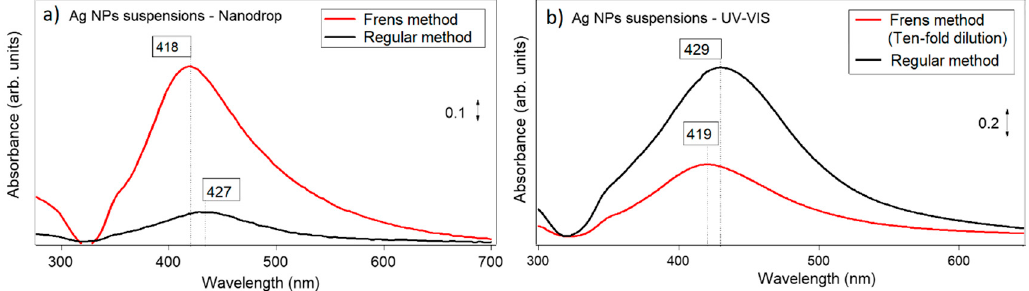
Figure 2. Absorbance spectra of Ag nanoparticles obtained with the regular method and with the Frens method, using a Nanodrop instrument ( a ) and a UV-Vis spectrometer ( b ). The suspension obtained via the Frens method exceeded the maximum measurement of the UV-VIS spectrometer ( b ); for this reason, the suspension was diluted by a factor of 10.